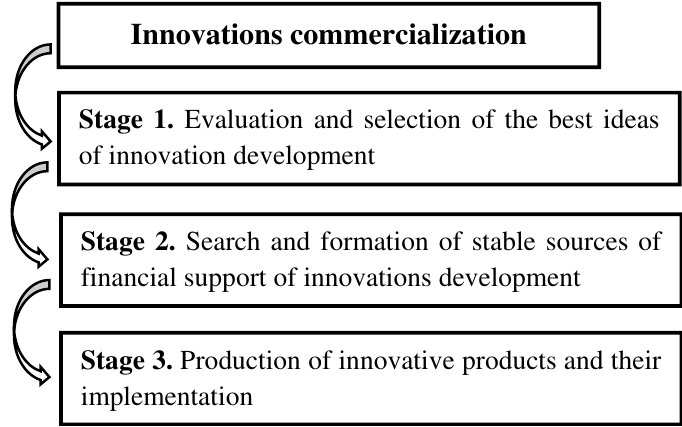
Fig. 1. The process of innovations